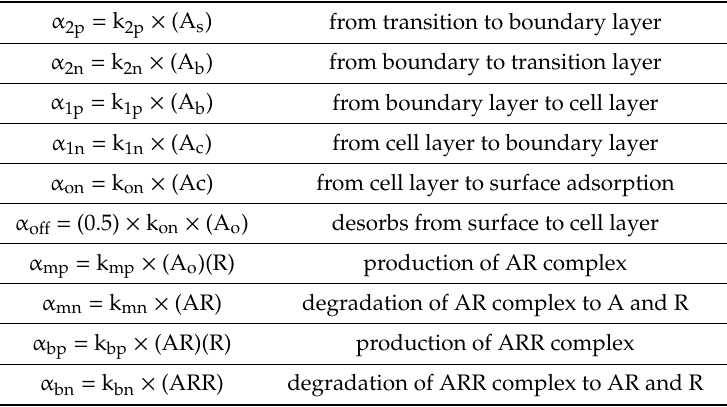
Table 2. Values of ten reaction propensity functions used in the